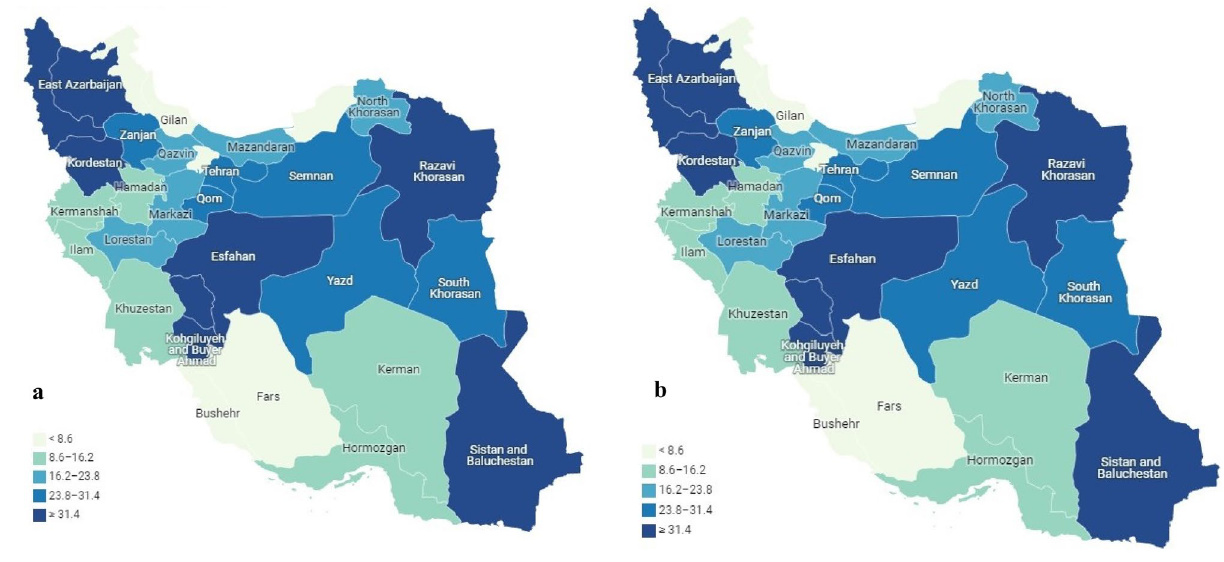
Figure 2. Distribution of deaths due to CVD per 100,000 by provinces of Iran in 1990 ( a ) and 2019 ( b ).